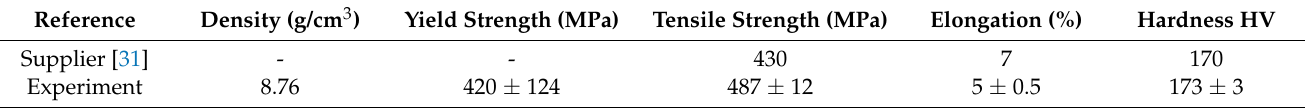
Table 5. Overview of the determined mechanical–technological properties.